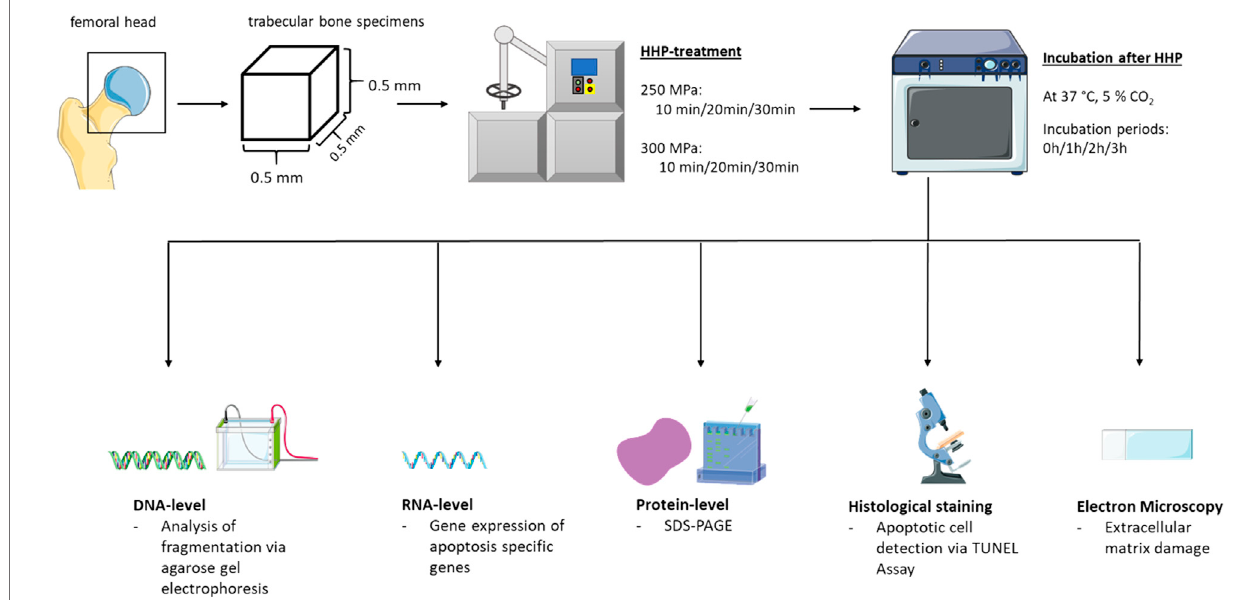
FIGURE 1 | Schematic overview of the methods